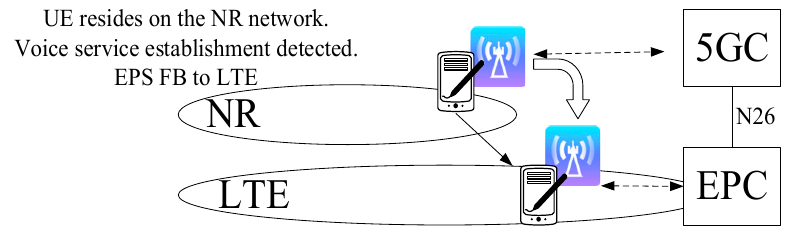
Figure 5. EPS Fallback.